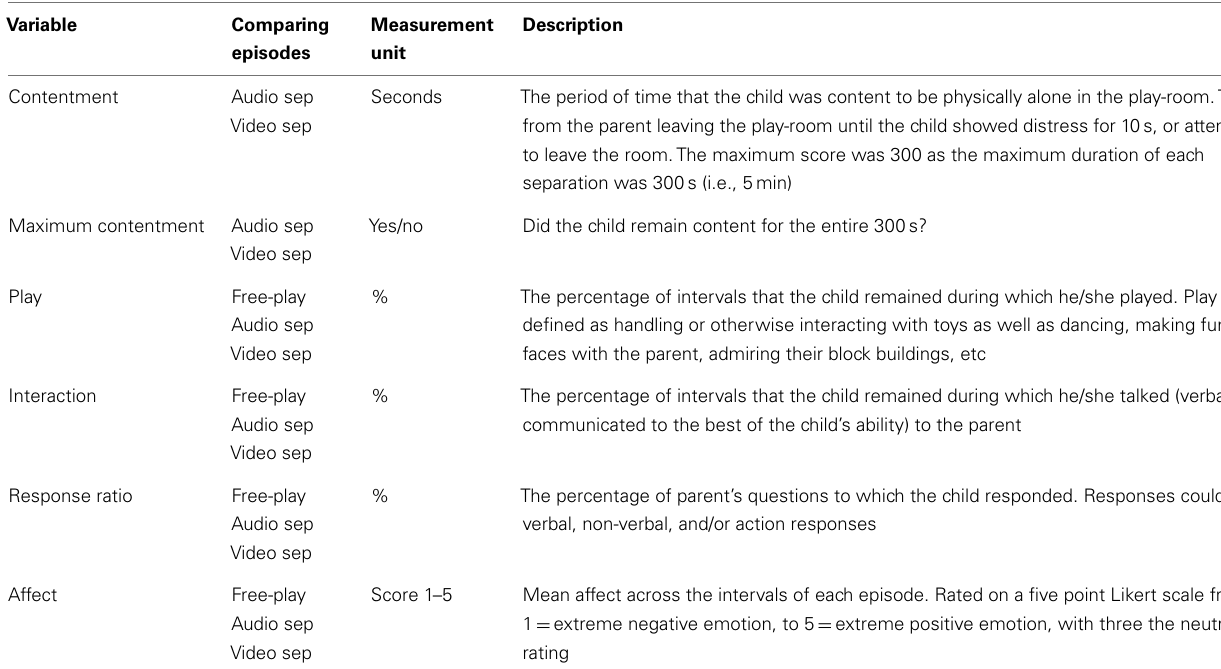
Table 2 | Descriptions of variables.